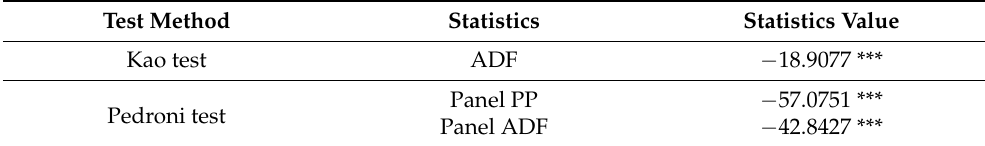
Table 3. Co-integration tests of variables.